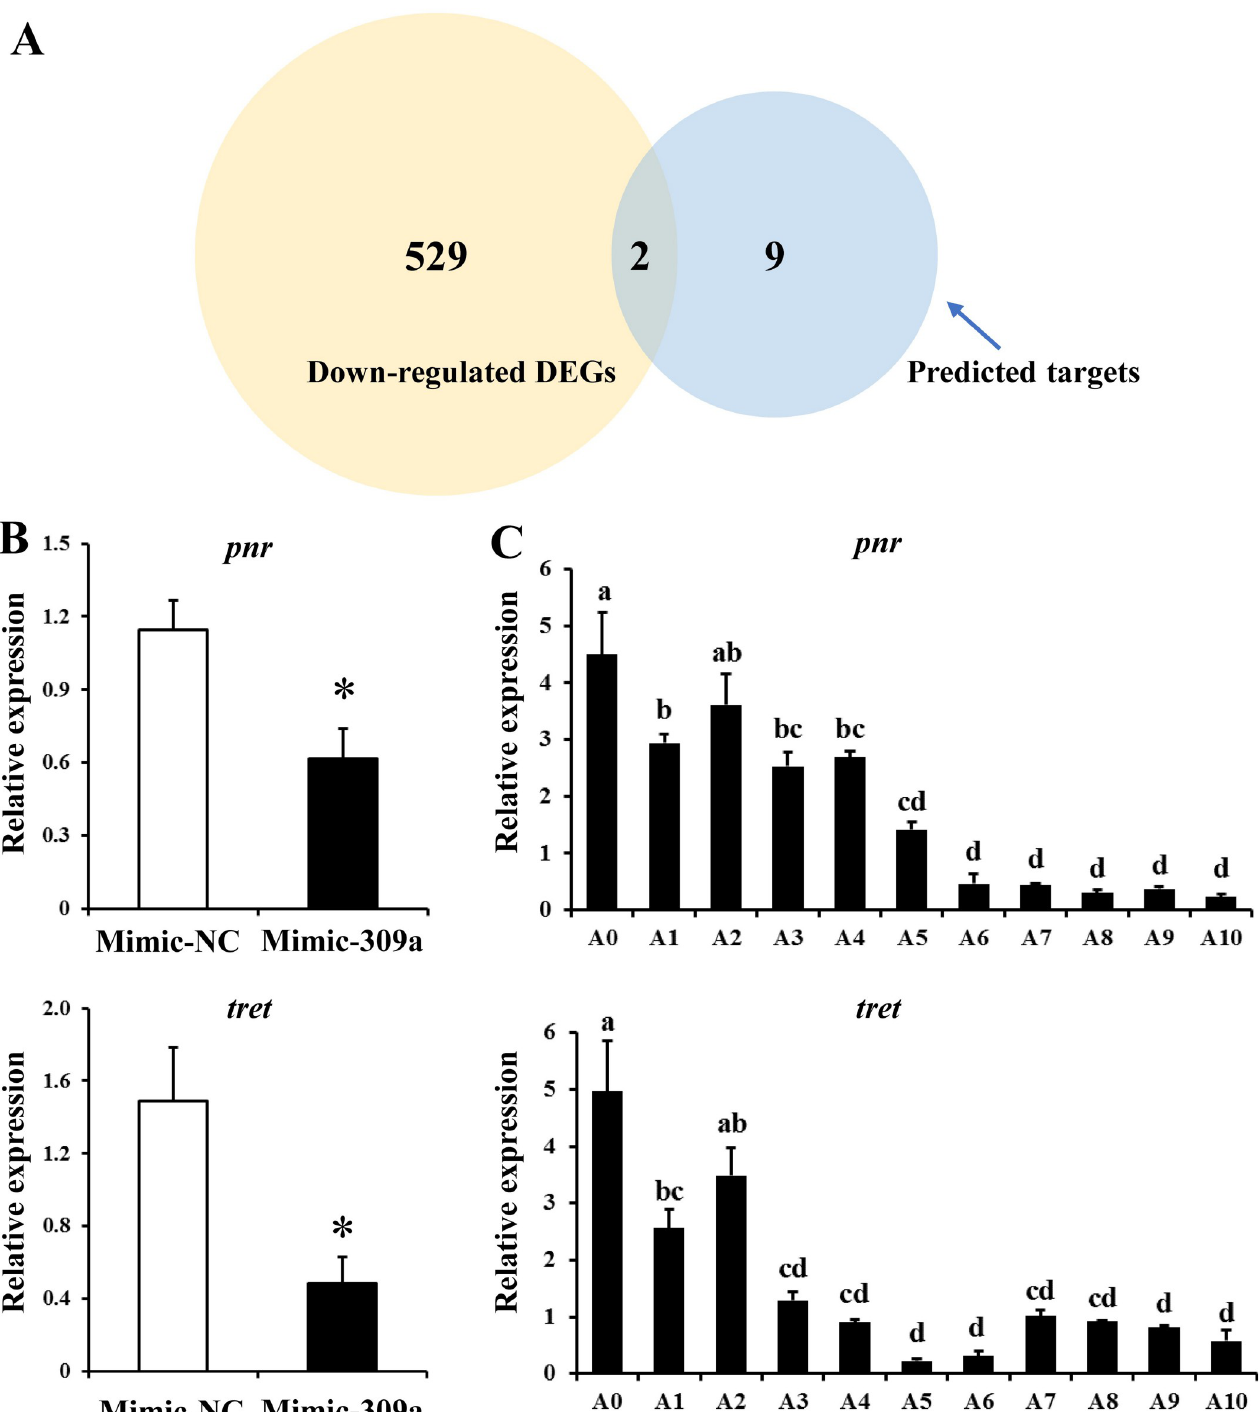
Fig 3. Exploration of miR-309a targets in B . dorsalis . (A) Venn diagram showing the overlapping down-regulated DEGs after miR-309 overexpression with in silico-predicted target genes by co-analysis using four prediction software programs. (B) Relative expression of the overlapping genes pnr and tret after miR- 309a overexpression. (C) Temporal expression of pnr and tret . Data are means ± SE (error bars) of four biological replications. a - tubulin and rps3 as reference genes were used to normalize the expression of predicted mRNAs. The differences between means were analyzed by Student’s t test. For the significance test: � P < 0.05. Different letters above the bars indicate significant differences of pnr and tret in different developmental stages of the ovary (Tukey HSD, ANOVA, P <